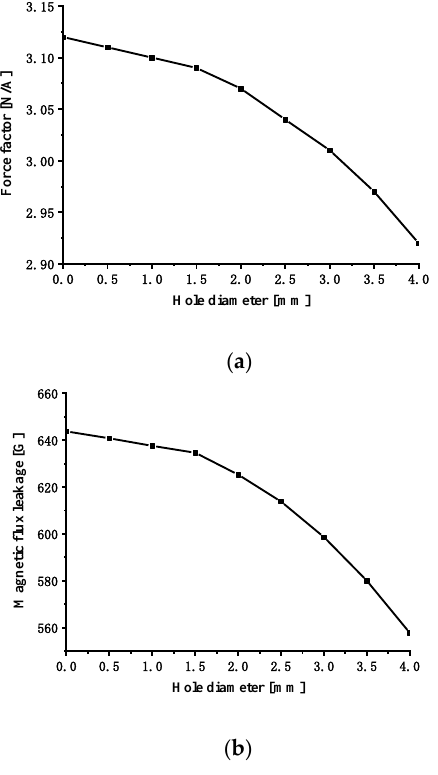
Figure 8. Analysis results according to di ff erent hole diameters: ( a ) force factor and ( b ) magnetic flux